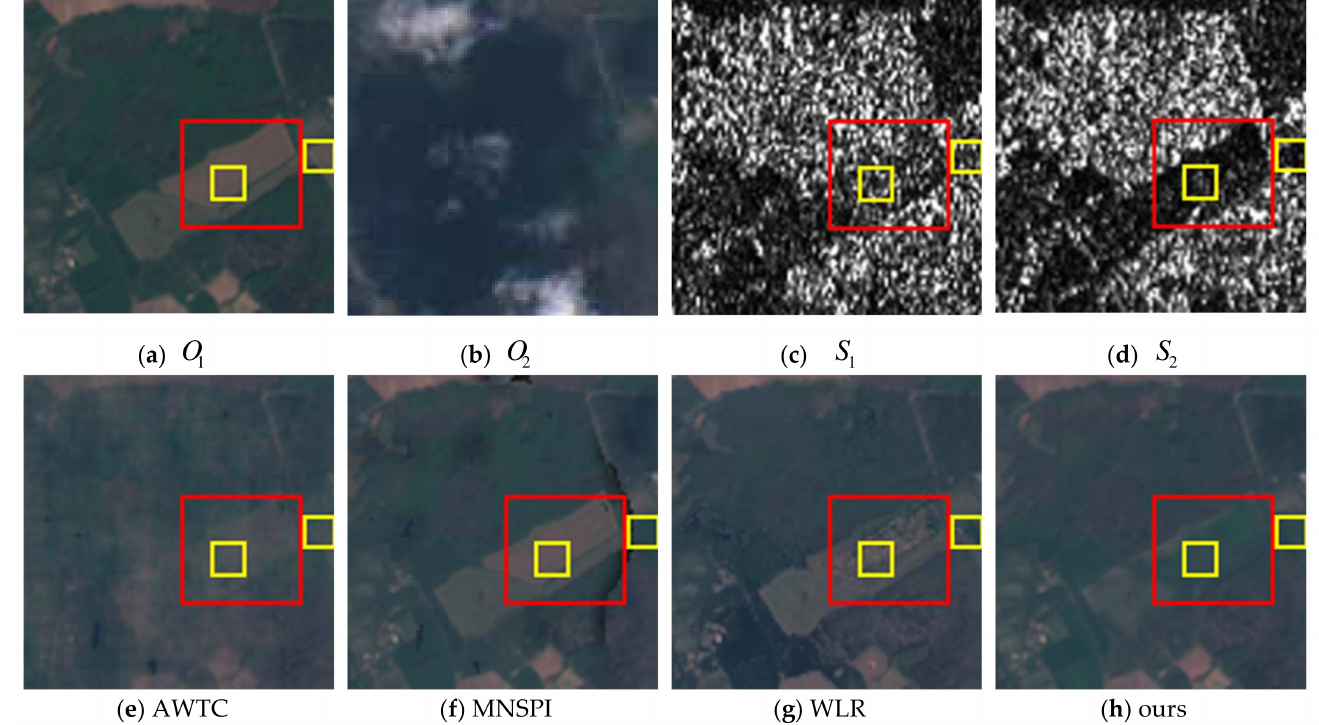
Figure 6. Magnified area of real experiment results. From S 1 and S 2 , we can see obvious ground information change. Moreover, we observe from O 1 , S 1 and S 2 ,that the two areas boxed in yellow share the same ground information. In the results of three comparison methods, the two areas in yellow boxes are different while in the result of our method, the two areas share the same spectral information.